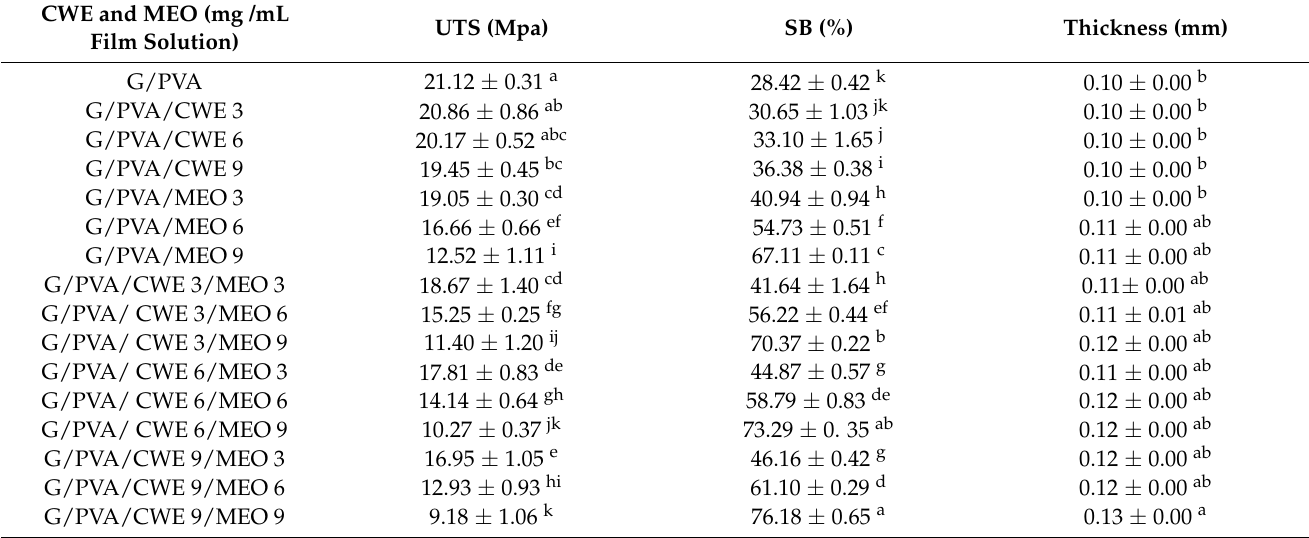
Table 2. Mechanical properties and thickness of the biodegradable active